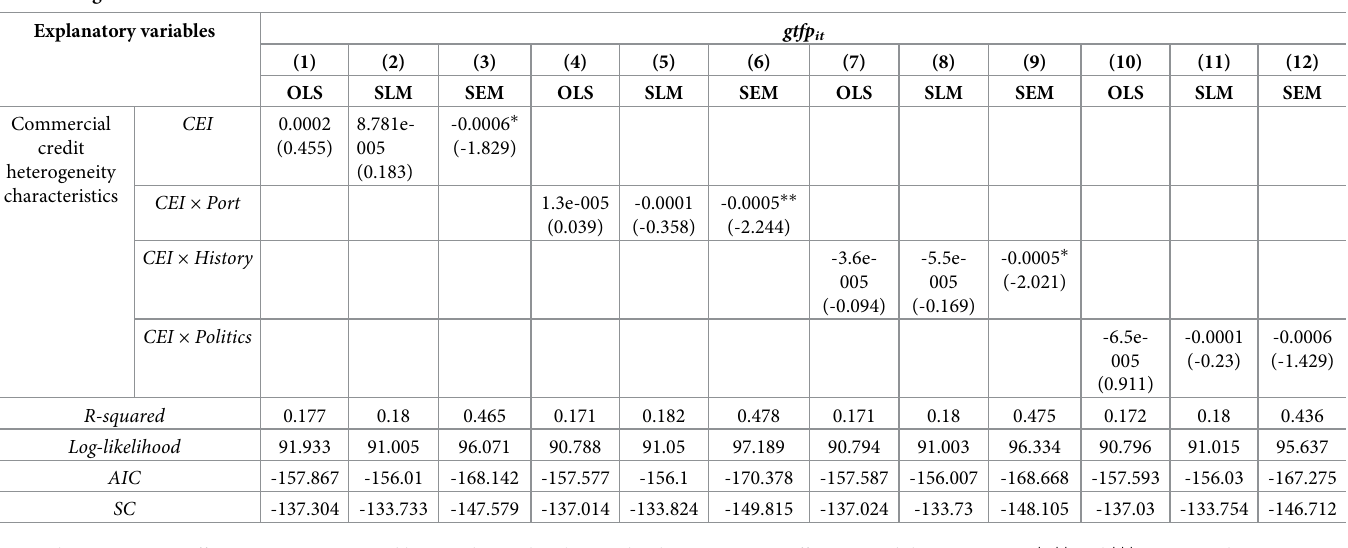
Table 5. Regression